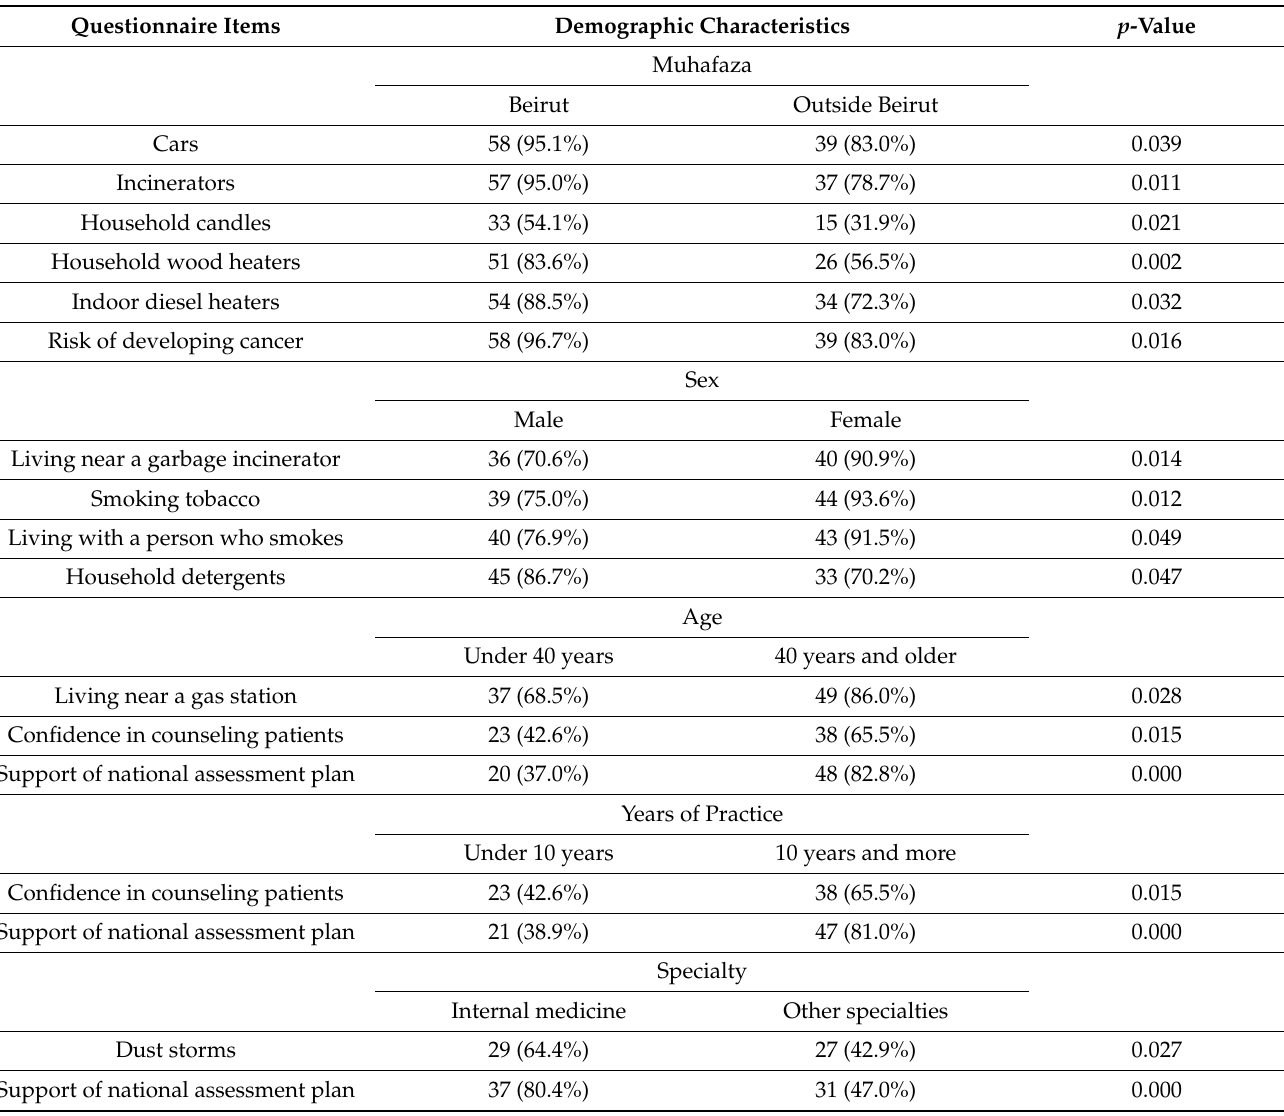
Table 5. Distribution of the answers among the different subgroups of the sample, divided according to demographics.